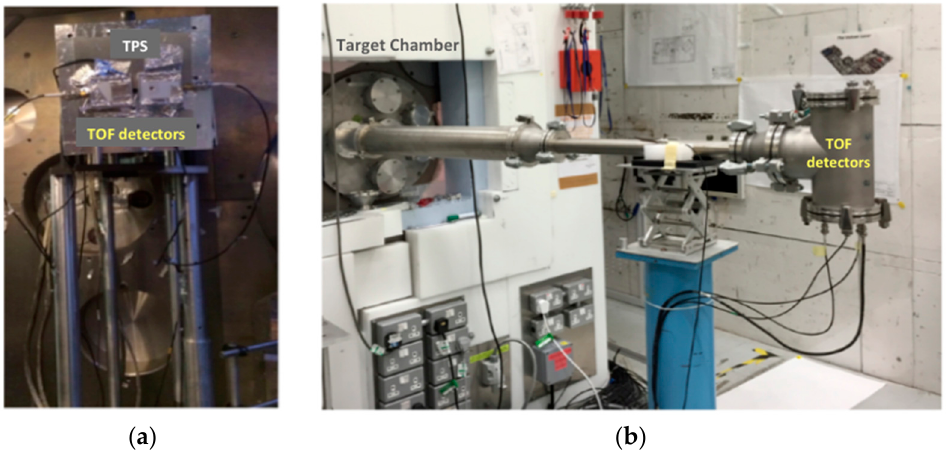
Figure 4. ( a ) Picture of the detectors installed in target chamber; ( b ) Picture of the experimental setup.